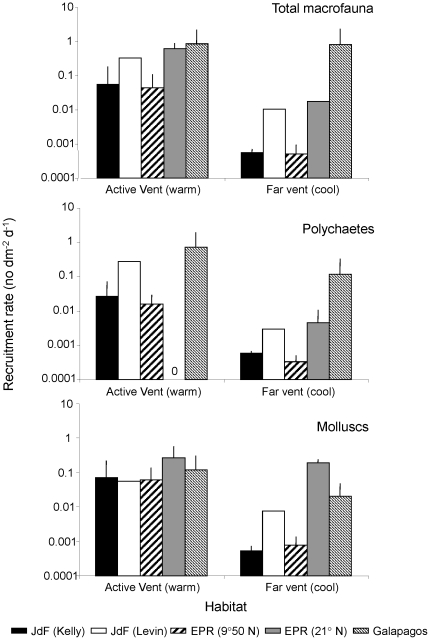
Rate of recruitment of total macrofauna, polychaetes and molluscs (+SD) at different vent habitats.These rates are measured near the orifice of an active vent or at vents with warm fluids, and at ∼10 m from an active vent or at vents with cool fluids. Data are from: JdF(Kelly) = [10]; JdF(Levin) = Levin unpublished data; EPR(9°50) = [30]; EPR(21°), Galapagos = [14].